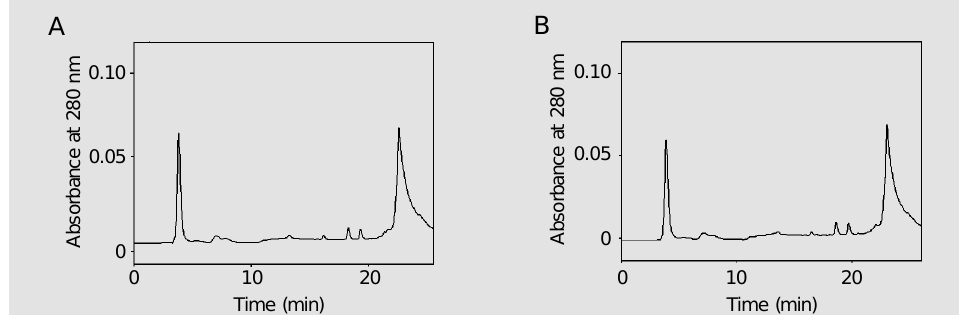
Figure 2. Hydrolysis of the oxidized ß-chain of insulin by ZapA. A solu- tion of oxidized ß-chain (20 µM) was incubated with 2.8 pM puri- fied native ZapA in 50 mM Tris- HCl and 2 mM CaCl 2 , pH 8.0, at 37 º C for 3 h. The hydrolysis prod- ucts were analyzed by HPLC as described in Material and Meth- ods. The chromatogram in panel B shows the profile of the intact polypeptide, and panel C shows the production of the fragments generated by the incubation with ZapA. The bonds cleaved by ZapA, indicated by arrows in the se- quence of the ß-chain of insulin (panel A), were determined by mass spectrometry as described fl in Material and Methods. = (cid:223) known cleavage sites; = newly detected cleavage site.